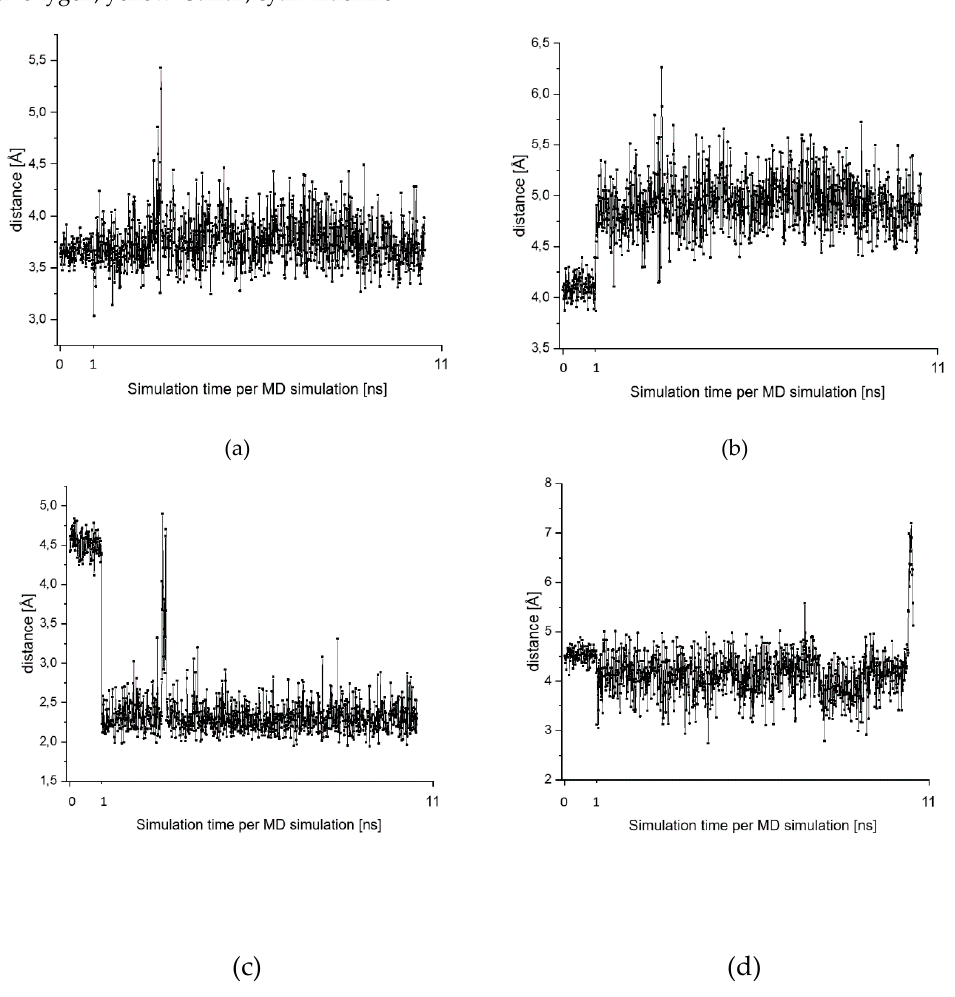
Figure 10. Charts ( a , b ) present the fluctuation of the distances between the sulfur center of Cys-25 and the carbon centers (CX) of the aromatic ring: ( a ) = distance S ... CH; ( b ) = S ... CNO 2 . ( c , d ) give the fluctuation in the distance of the Cys-S ... H-N hydrogen bond along MD 5 ( c ) and MD 6 ( d ). All simulations start from the pose in Figure 9.